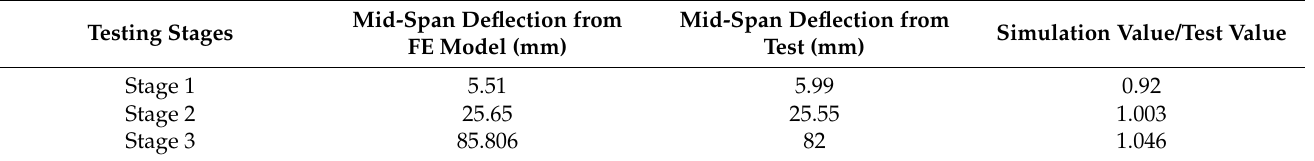
Figure 18. Comparison of load-strain curves of steel lower flange. Table 3. Comparison of simulation and test